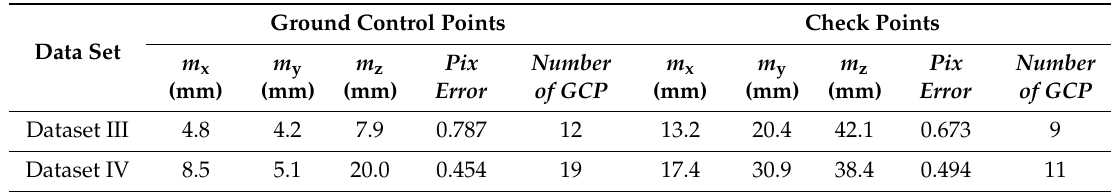
Table 5. Root mean-squared errors (RMSEs) of coordinates of the GCPs and checkpoints. Ground Control Points Check Data Set